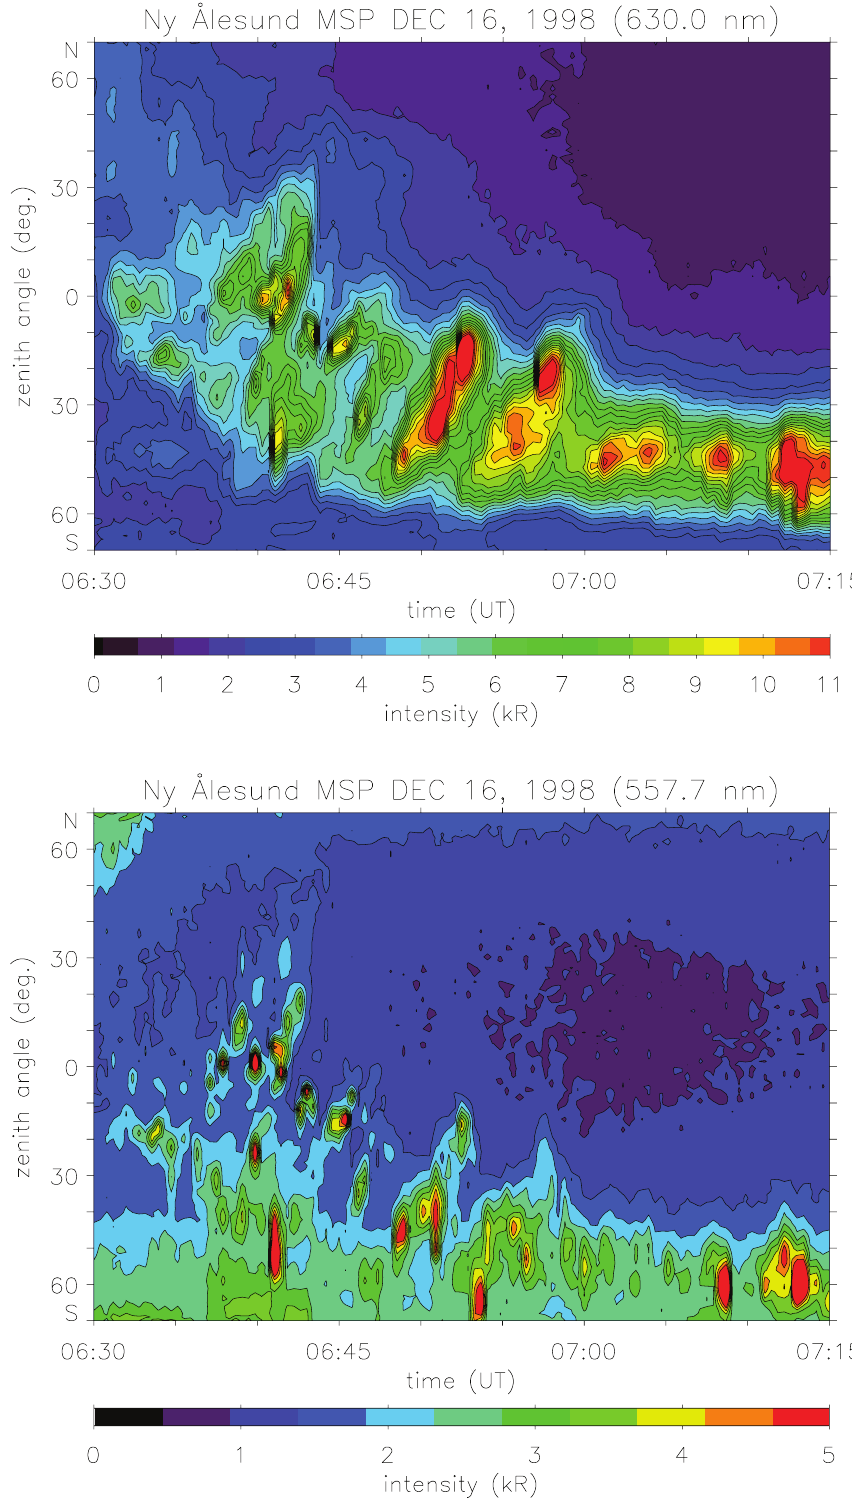
Fig. 7. MSP observations for the interval 06:30–07:15 UT on 16 December 1998. Upper and bottom panels show the red and green line emissions at 630.0 and 557.7nm, respectively. Same format as in Fig.